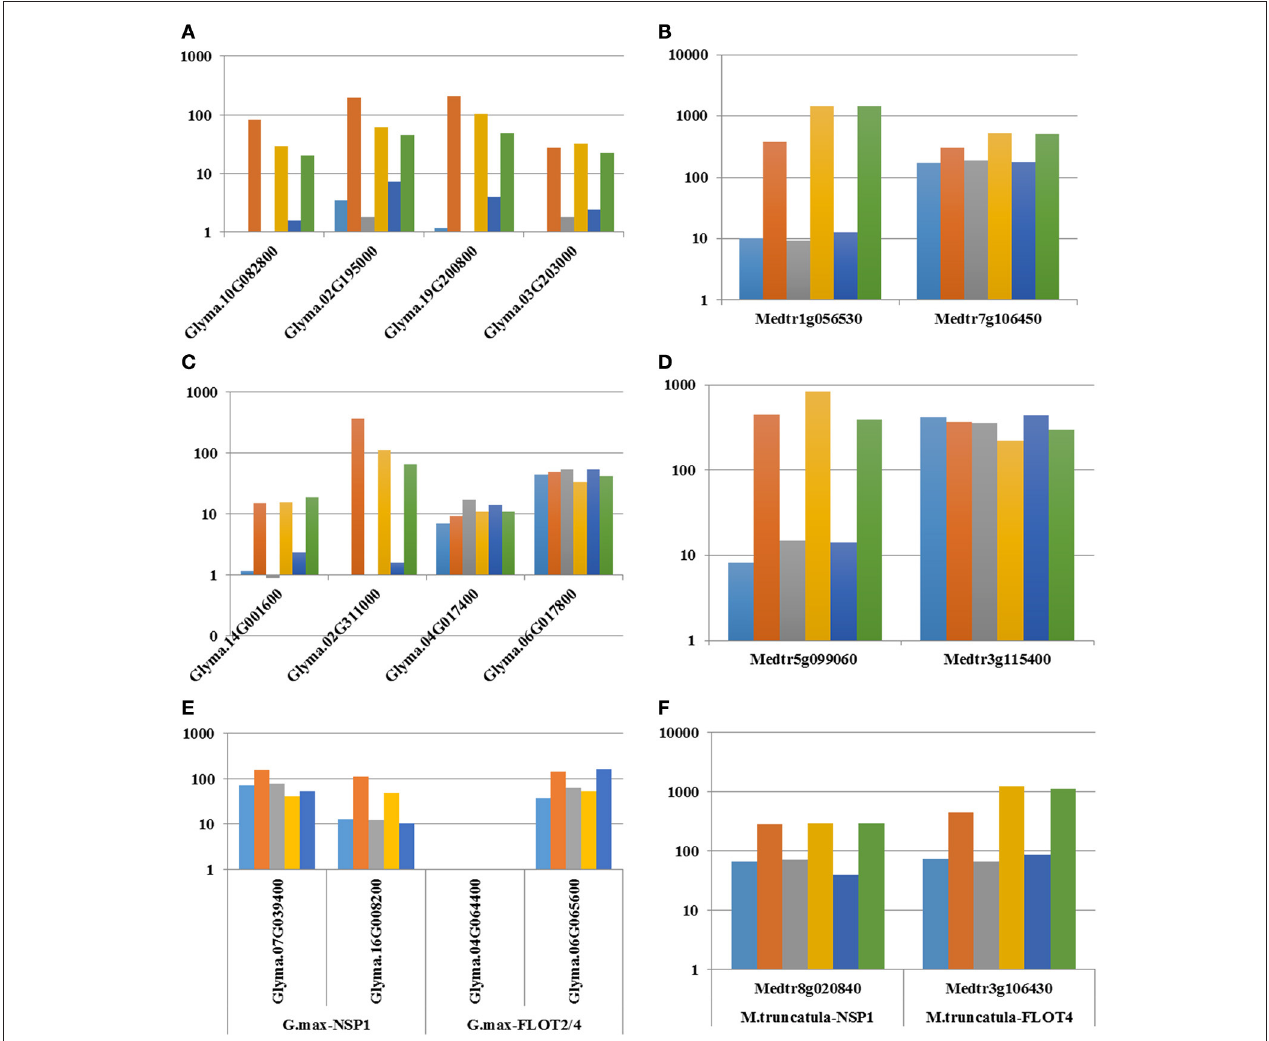
FIGURE 2 | Relative expression levels of NF-YA1/2 (A, B) , NIN (C, D) , NSP1, and FLOT2/4 (E, F) M. truncatula genes (B, D, F), and their G. max orthologs (A, C, E) in inoculated and mock-inoculated root hair cells. Gene IDs are highlighted on the x-axis. The relative expression levels of the genes (log10 scale) are indicated on the y-axis. Gene expression datasets were mined from the G. max and M. truncatula root hair transcriptomic datasets (Libault et al., 2010b; Breakspear et al., 2014). For G. max : blue, 12H UN; orange, 12H IN; gray, 24H UN; yellow, 24H IN; dark blue, 48H UN; and green, 48H IN; For M. truncatula : blue, 1D UN; orange, 1D IN; gray, 2D UN; yellow, 2D IN; dark blue, 3D UN; and green, 3D IN.